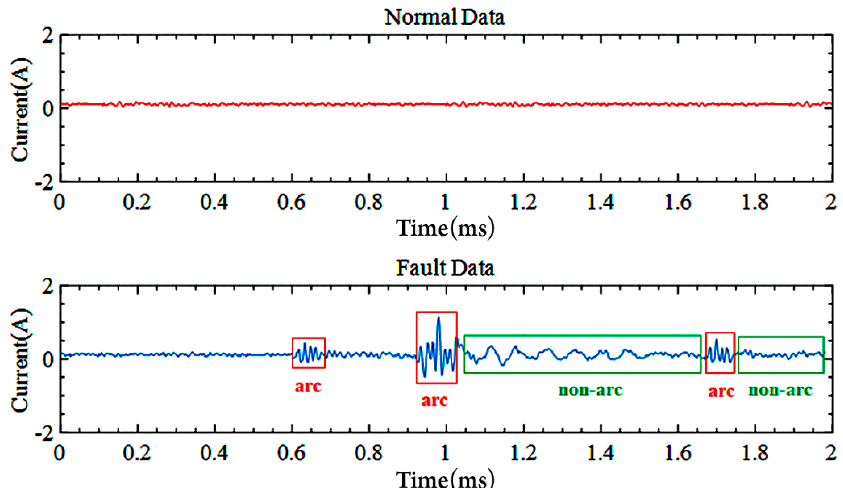
Figure 6. Comparison of waveforms between normal and arc fault conditions in the time domain.